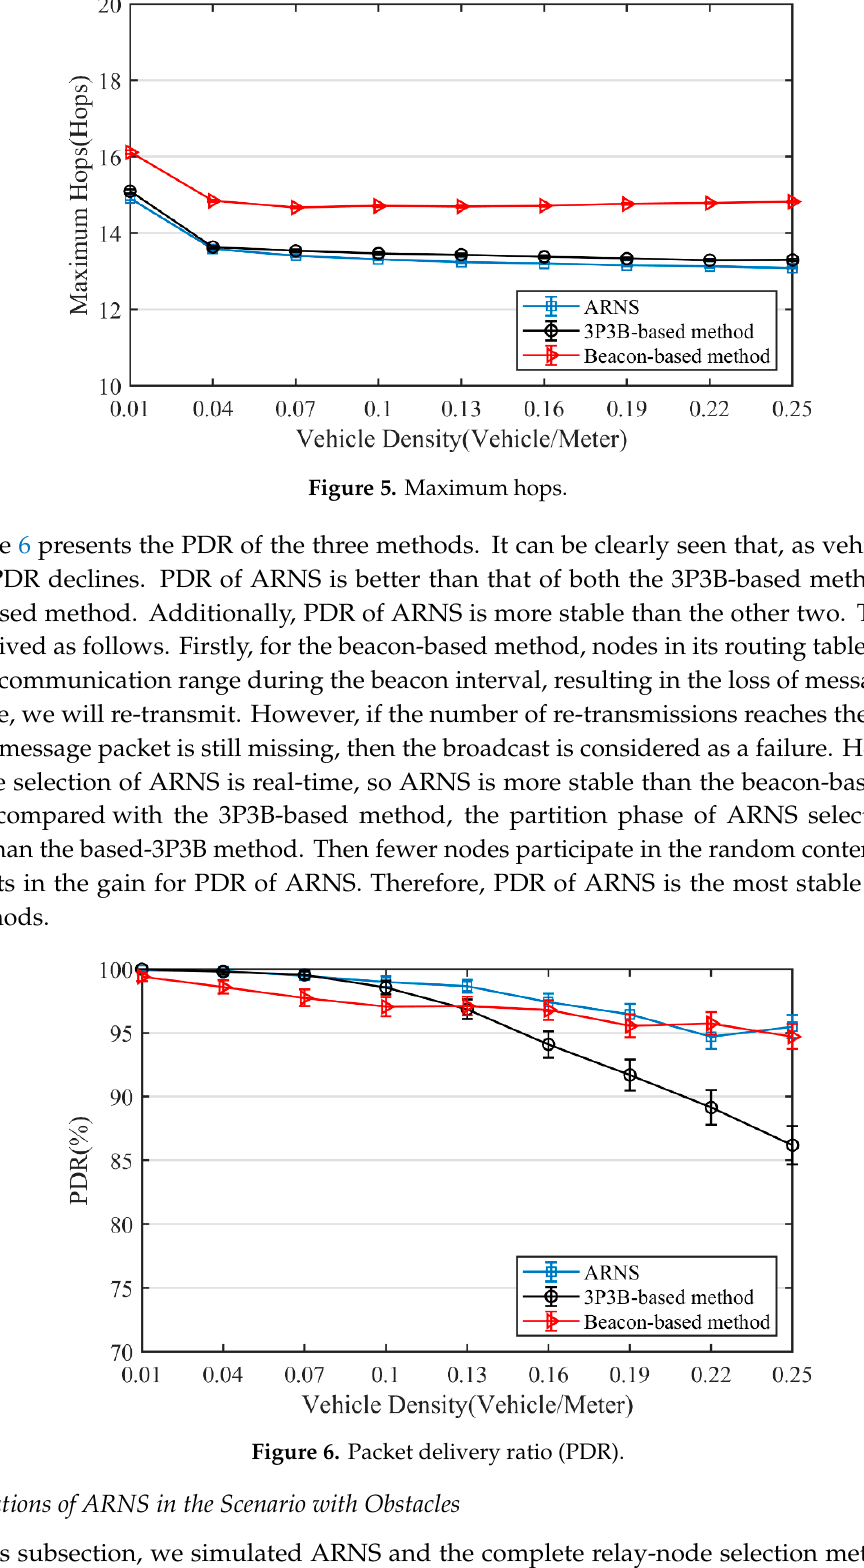
Figure 6. Packet delivery ratio Figure 6. PDR.